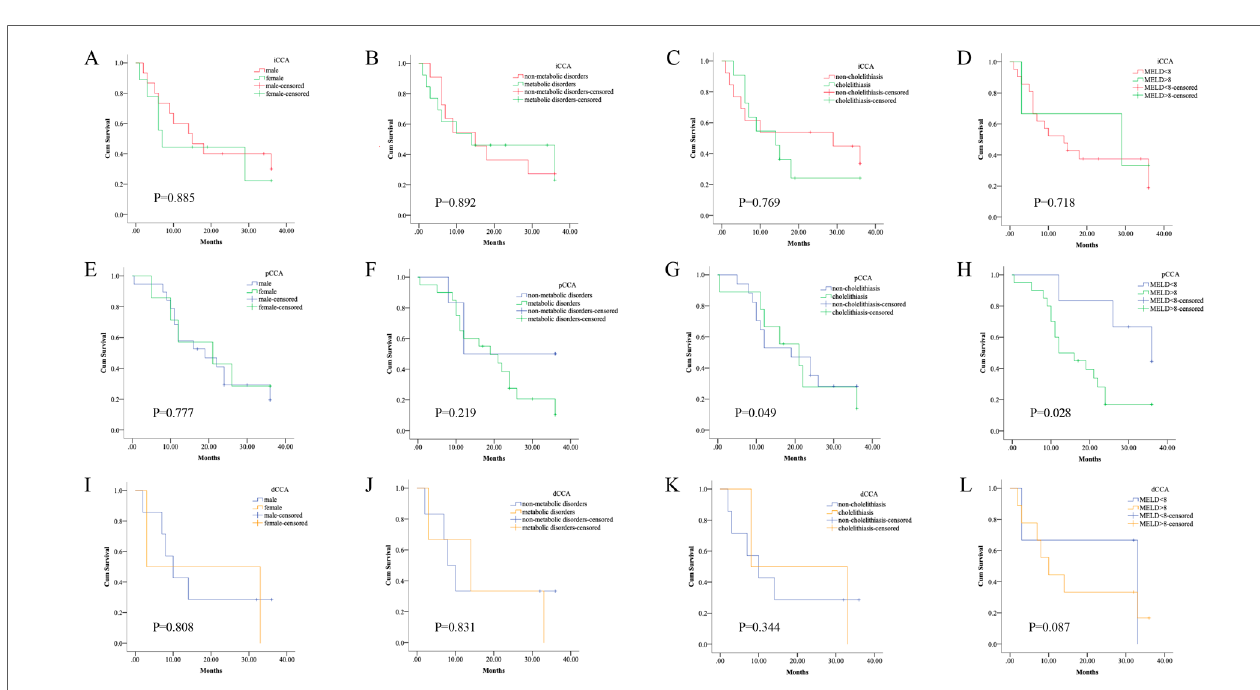
FIGURE 3 Survival of the subtypes of CCA patients by co-existing conditions. The subtypes of CCA patients were classi fi ed into different subgroups by sex, by the degree of jaundice, by the presence of cholelithiasis, or metabolic disorders, respectively. Kaplan – Meier curves show the different survival times. ( A – D ) There was no signi fi cant difference in the median survival time of the subgroups of iCCA patients based on different conditions, log-rank p >0.05. ( E – H ) There was a signi fi cant difference in the median survival time of pCCA patients with the presence of cholelithiasis, or with different levels of obstructive jaundice, log-rank p <0.05. However, there was no signi fi cant difference in the median survival time of the subgroups of iCCA patients based on the other conditions, log-rank p > 0.05. ( I – L ) There was no signi fi cant difference in the median survival time of the subgroups of dCCA patients based on different conditions, log-rank p